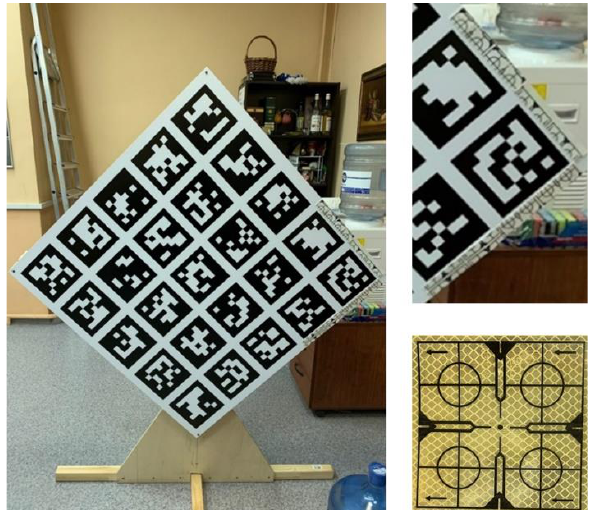
Figure 7. Calibration board. Light-reflection stripes are attached to the right edge of the board.